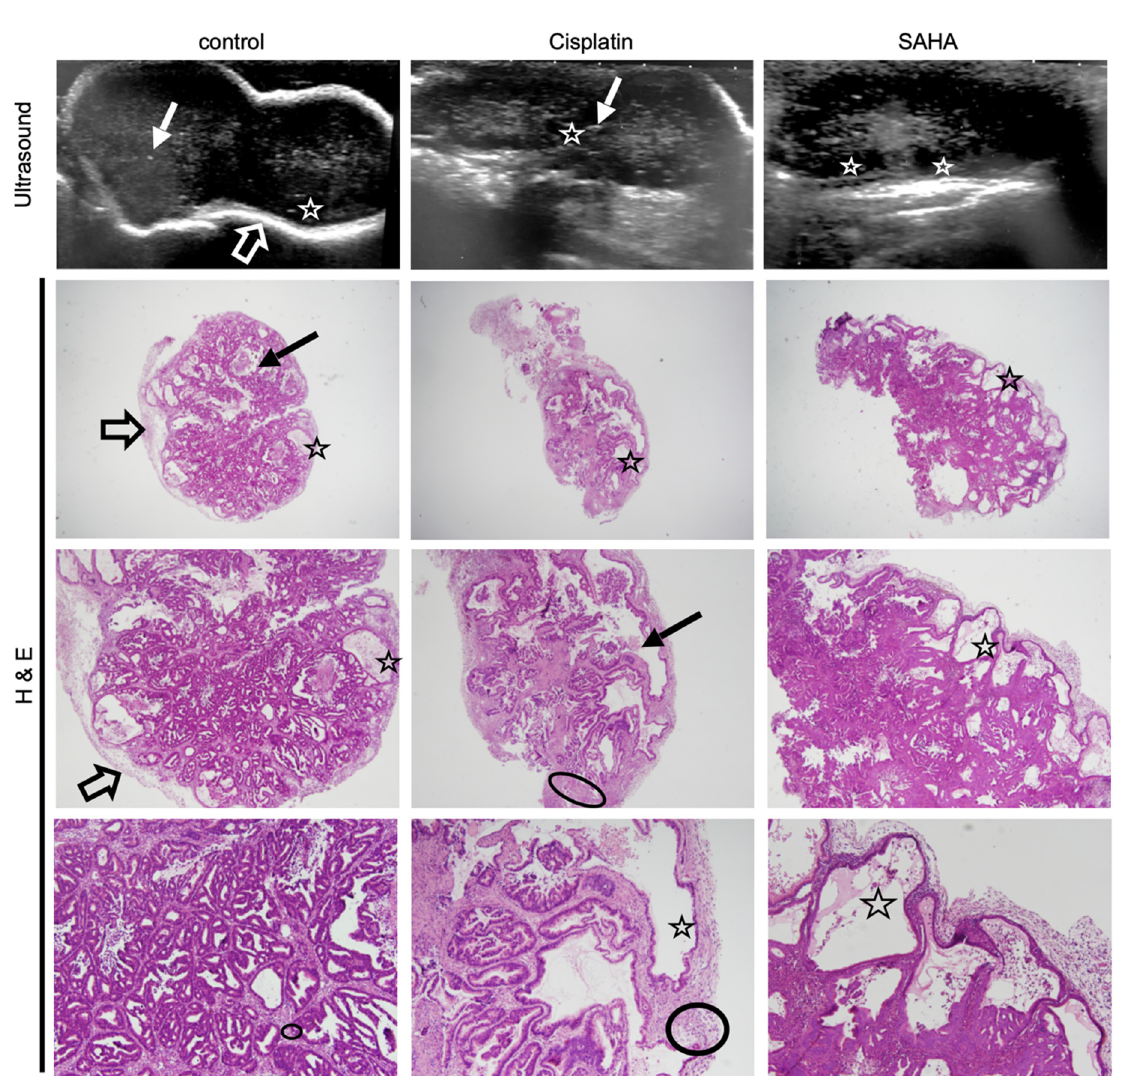
Figure 4. Histology confirms treatment-related sub-structural changes observed with ultrasound. Ultrasound images of a representative GXC-004 tumor from each treatment group (upper panel, day 23) compared to their corresponding histological slices (hematoxylin eosin staining, magnification ×2 (upper), ×20 (middle) and ×40 (lower)). Control tumors had sharper margins with a white peripheral rim (empty arrow), while treated tumors, especially SAHA-treated ones, were more lobulated. Some tumors (especially in the control group) presented scarce intraglandular necrosis, which could potentially explain the comet-tail artifacts observed on ultrasound (i.e., small central hyperechoic punctiform foci, plain arrow). Histology revealed a stromal predominance (circled) in cisplatin-treated tumors compared to the primary tumor and controls, with a stroma/gland ratio > 50%. Cysts (star) were frequently observed with an ultrasound (visible when >2 mm) in the periphery of SAHA-treated tumors, less frequently in cisplatin-treated tumors. This finding was confirmed by histology (star).